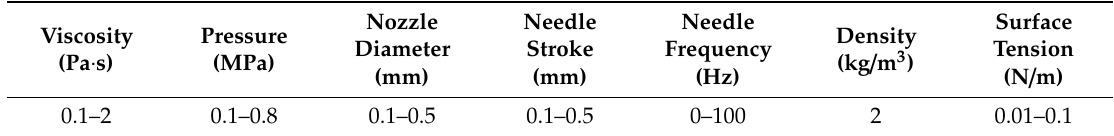
Figure 3. Boundary conditions of the simulation model: ( a ) Gambit mesh model; ( b ) computational fluid dynamics (CFD) simulation model. Table 1. Ranges of simulation parameter values.